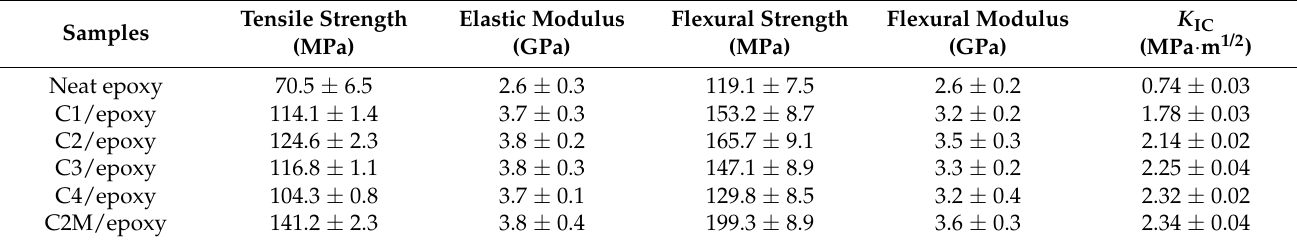
Table 2. Mechanical and thermal properties of neat epoxy and its composites.